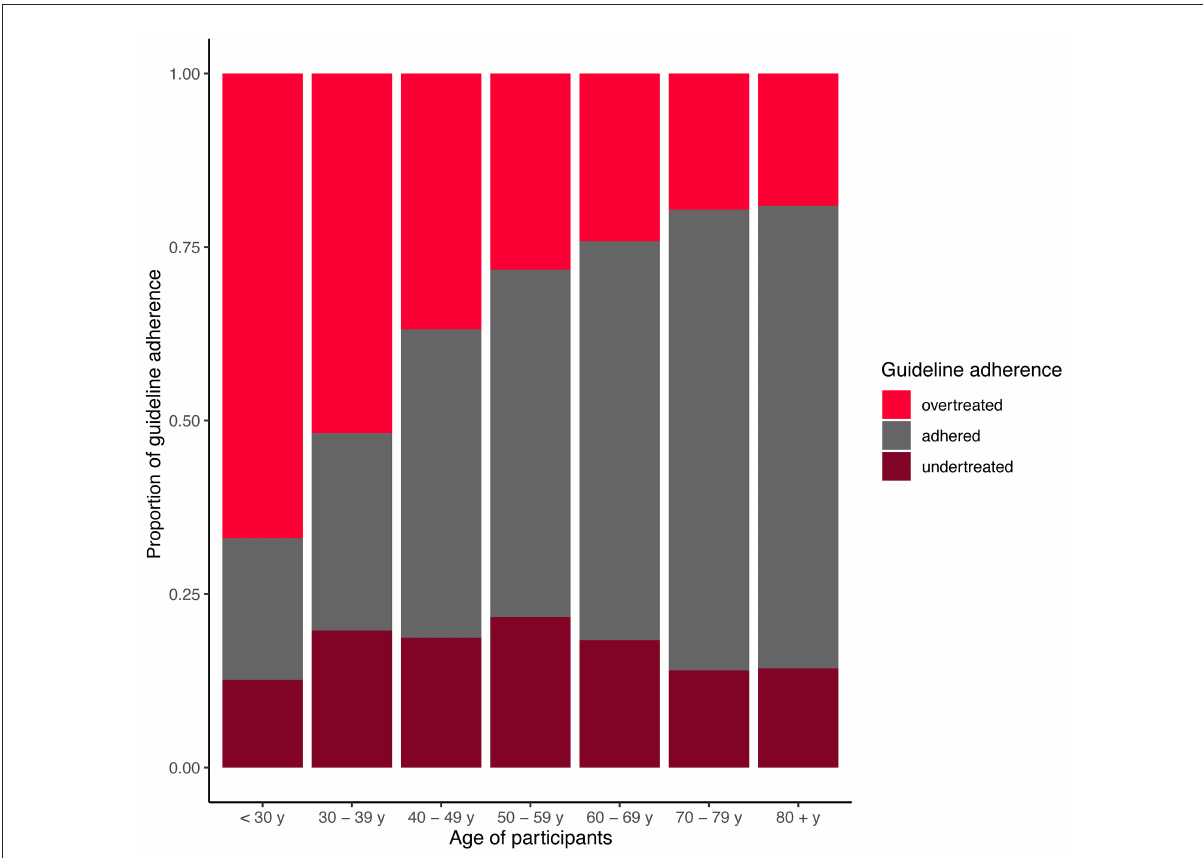
FIGURE2 Adherence to evidence-based guidelines according to patients’ age. Proportions are